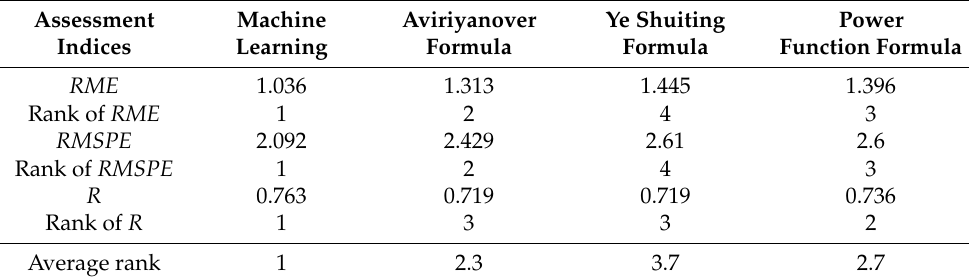
Table 4. Analysis of the assessment indices for machine learning and formula fitting.